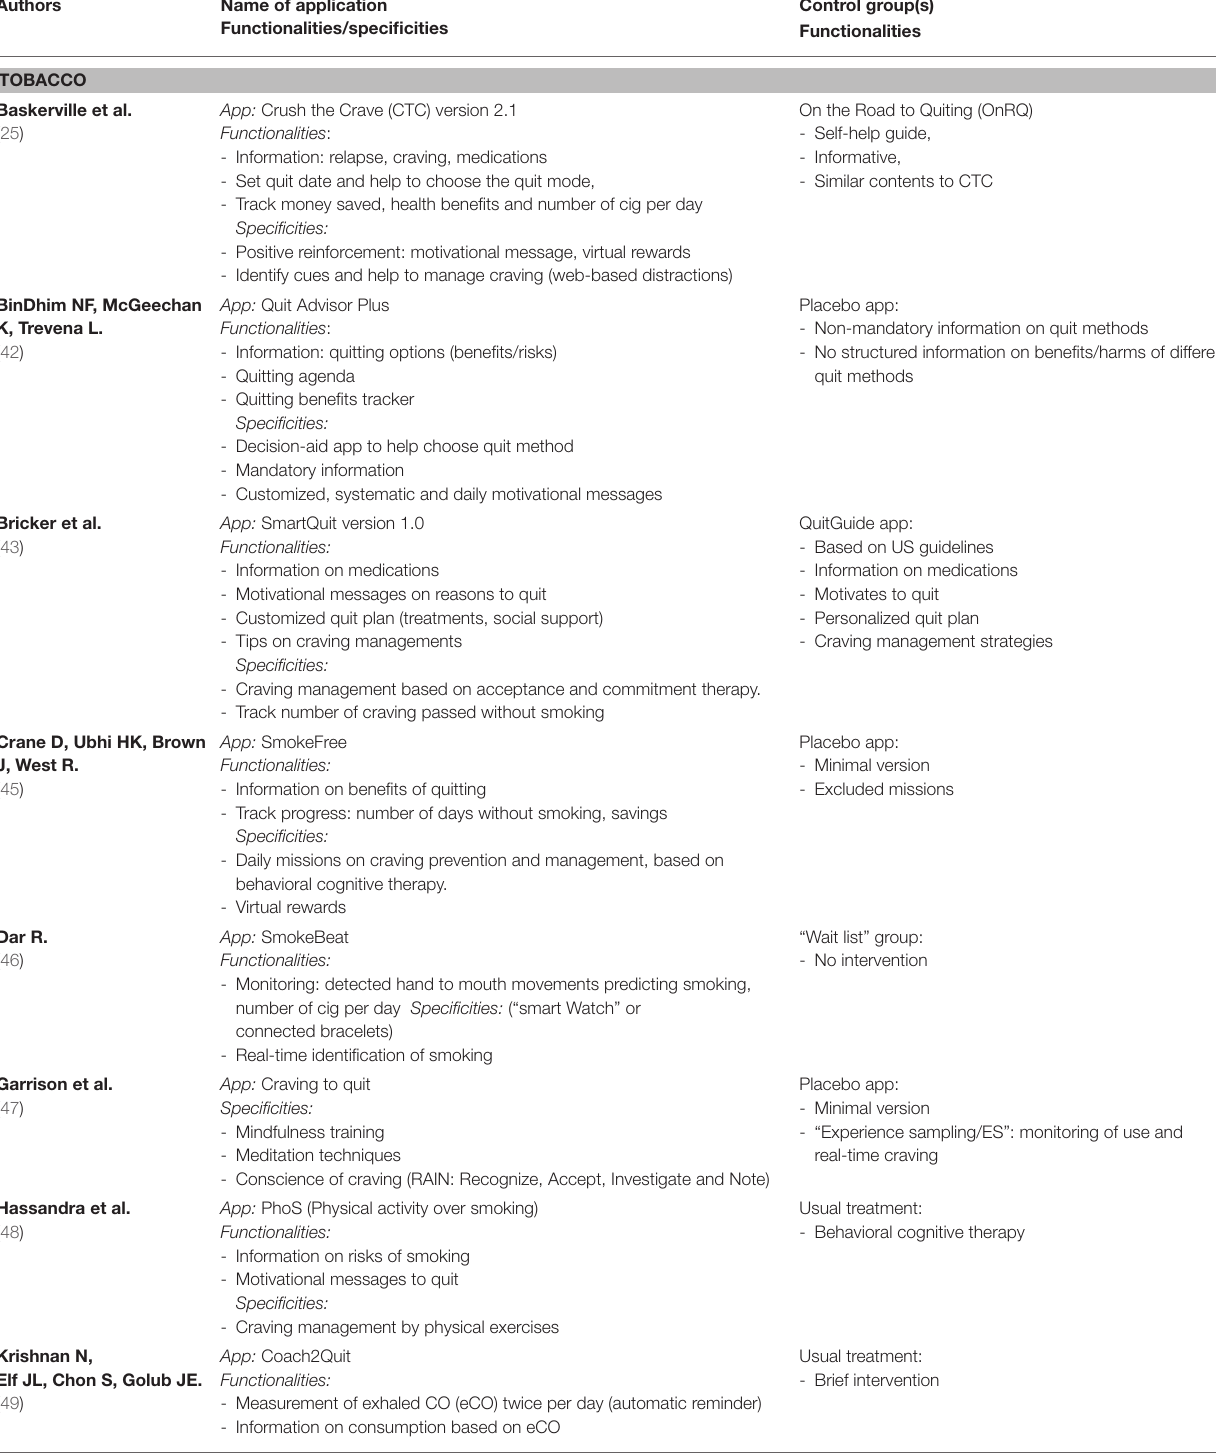
TABLE 4 | Characteristics of interventional and control groups (ranged by addictive disorder).